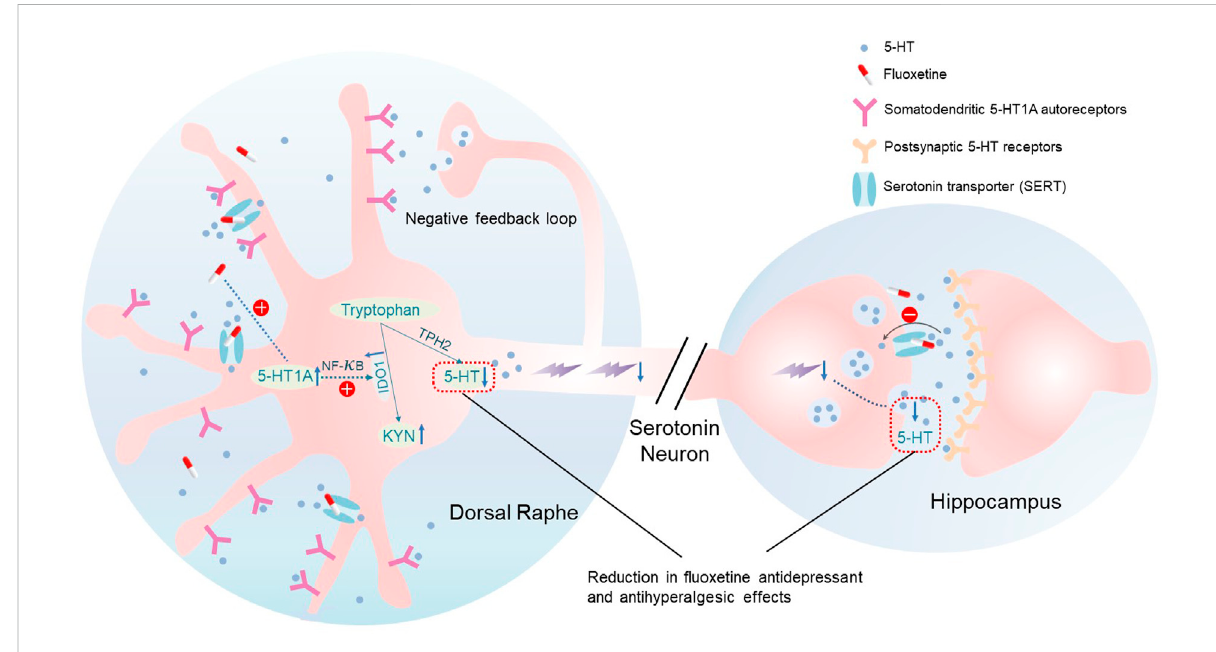
FIGURE 7 Schematic of the reduction in fl uoxetine